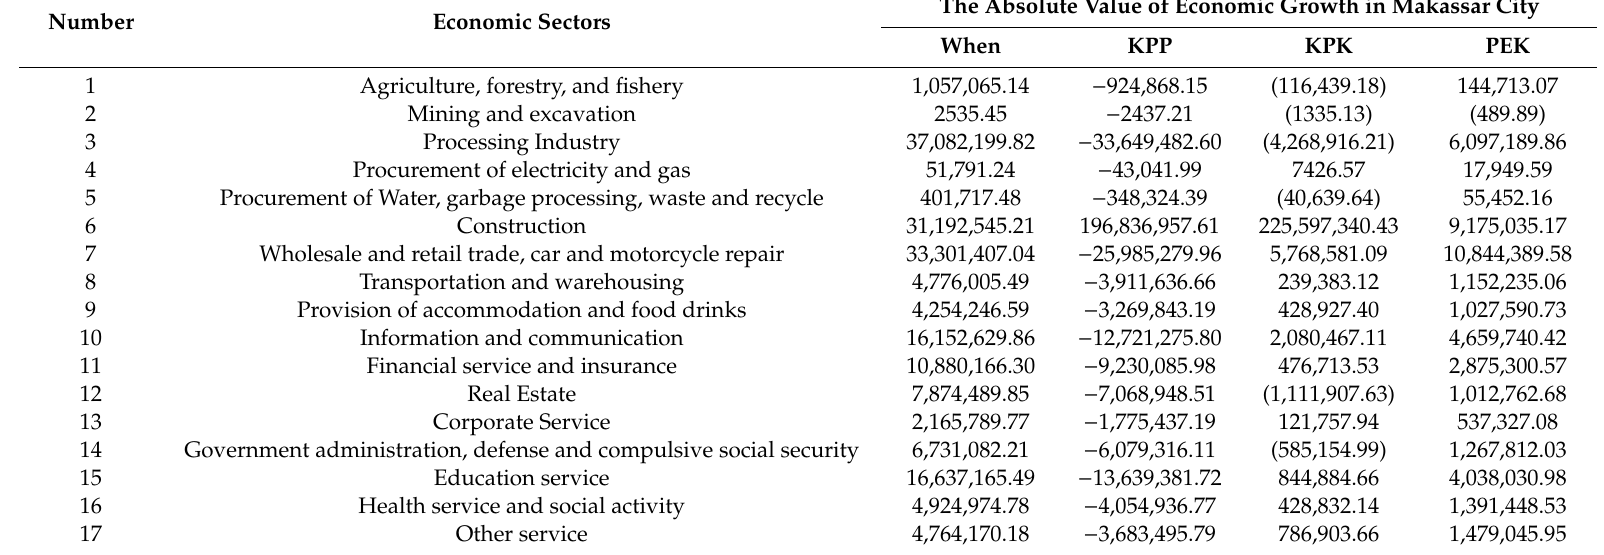
Table A2. Absolute Value of Economic Growth in Makassar